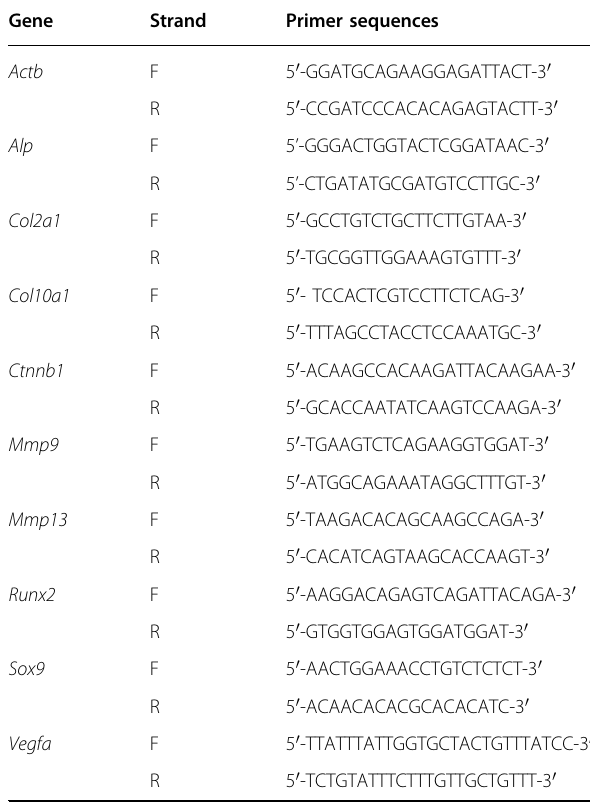
Table 1 qPCR primer sets